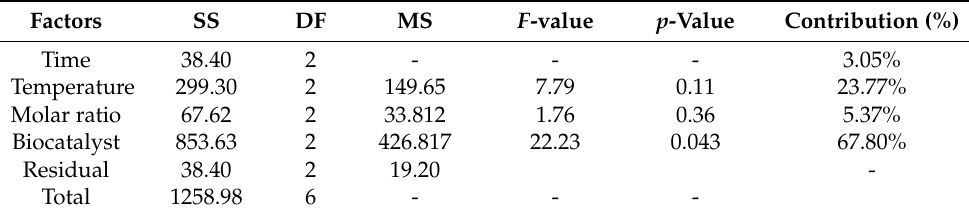
Table 3. Analysis of variance of the parameters that affect the esterification of babassu oil.